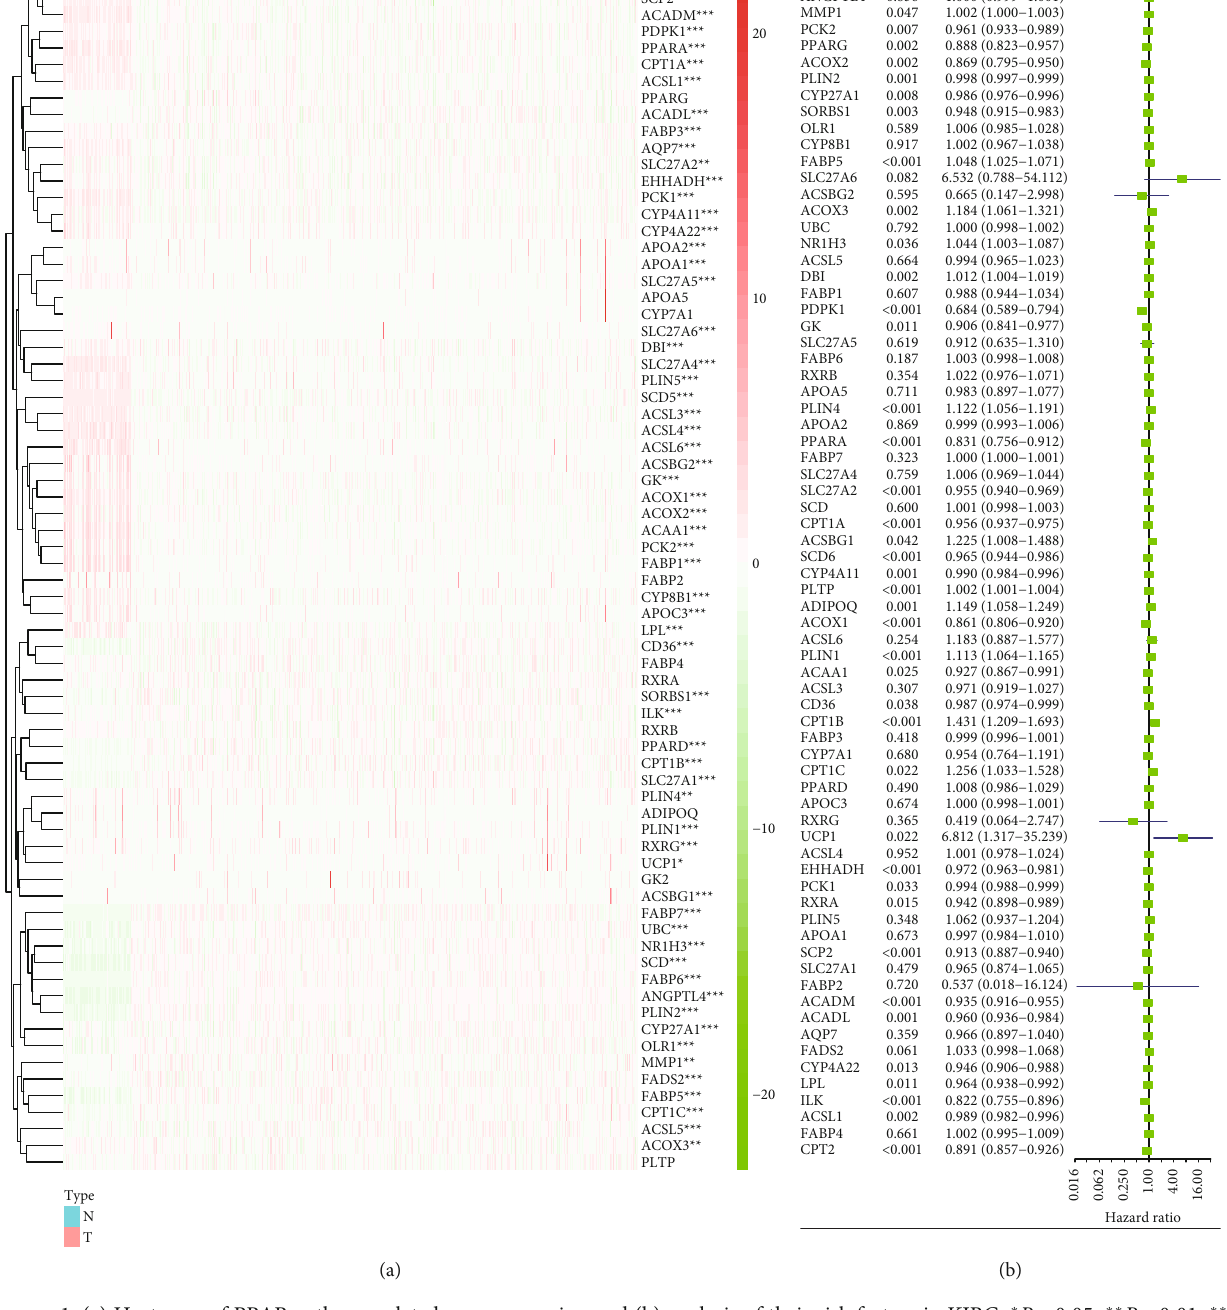
Figure 1: (a) Heat map of PPAR pathway-related gene expression and (b) analysis of their risk factors in KIRC. ∗ P < 0 : 05 ; ∗∗ P < 0 : 01 ; ∗∗∗ P < 0 : 001